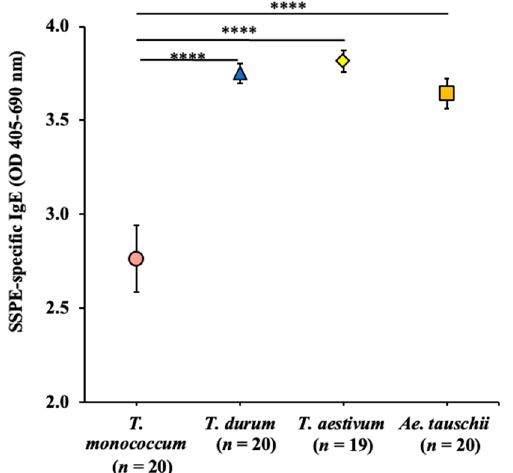
Figure 10. A comparative map of the intrinsic allergenicity sensitization potential of SSPEs from diploid, tetraploid, and hexaploid wheats. The changes in SSPE-specific IgE antibody (Ab) levels after the 8th skin exposure to SSPEs from the respective wheats are shown in the figure. **** p < 0.001, one-way ANOVA and Tukey’s post hoc tests. n : number of mice, SSPE: salt-soluble protein extract.